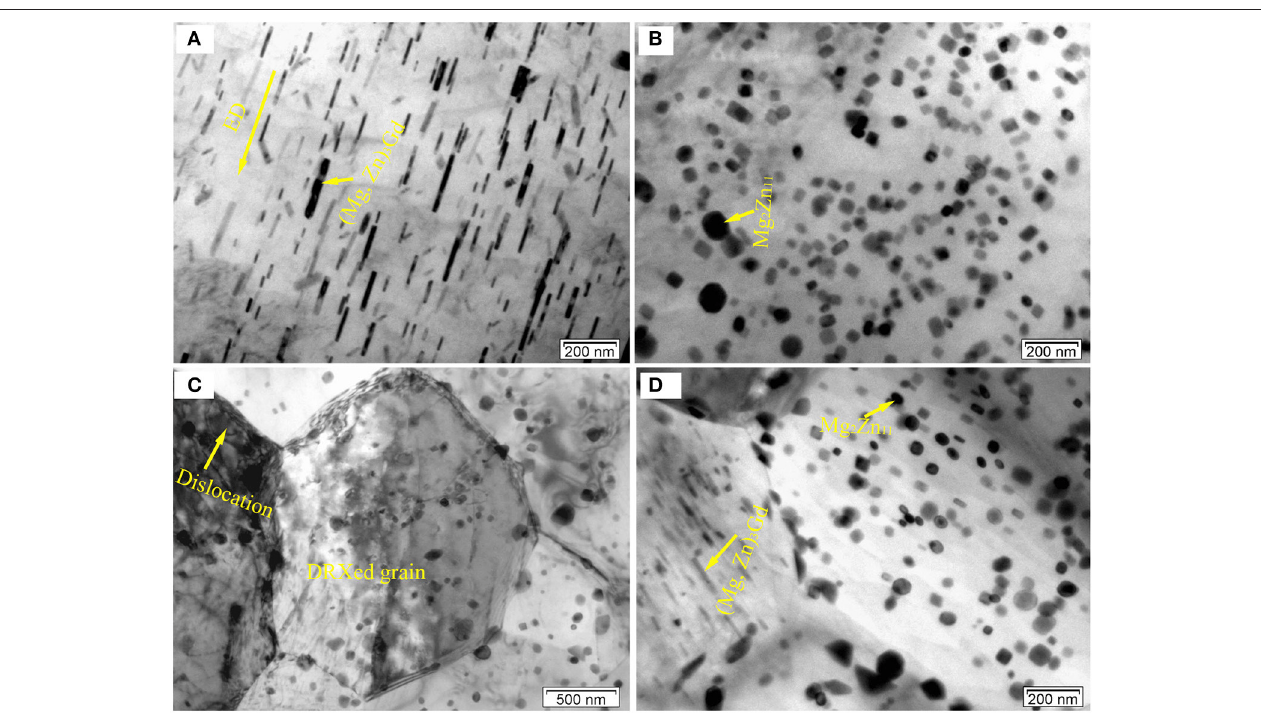
FIGURE 9 | Typical TEM BF images of the E350 samples: (A) A large amount of rod-like precipitates; (B) A large amount of granular precipitates; (C,D) Rod-like and granular precipitates at the grain boundaries or within crystals.